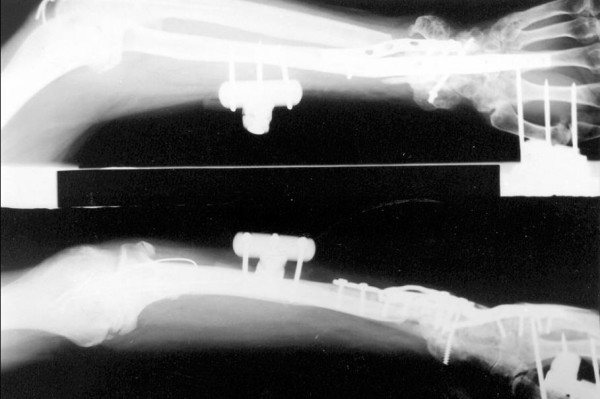
The fractures in the elbow region united and the patient had a good result according to Mayo Elbow Performance Index after 20 months from injury (with a complete recovery of the ulnar nerve the third month from injury). However due to persistent wrist instability and pain he underwent later a carpal arthrodesis.